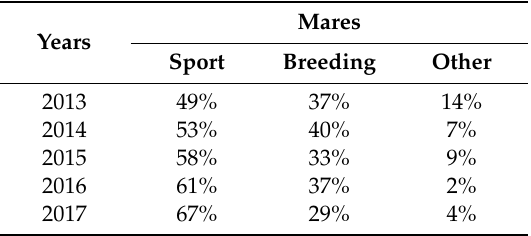
Table 1. The structure of mare insemination in Europe, including the division into their type of use ( N = 2480), developed based on reports from European insemination stations.